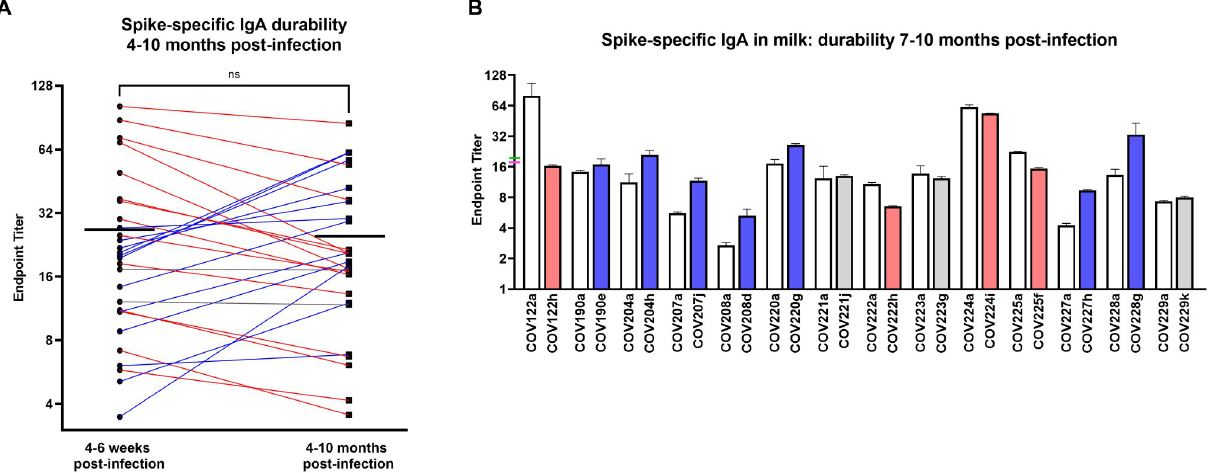
Fig 3. The Spike-specific IgA response in milk after SARS-CoV-2 infection is highly durable over time. (A) IgA endpoint titers determined from Spike ELISA for 28 pairs of milk samples obtained from COVID-19-recovered donors 4–6 weeks and 4–10 months after infection are shown. Mean endpoint values for each group are shown. Blue lines: > 10% increase, red lines: > 10% decrease, grey lines: < 10% change. NS: not significant. A paired t- test (2-tailed) was used to assess significance. (B) IgA endpoint titers for a subset of 14 paired samples obtained 4–6 weeks and 7–10 months after infection. Mean with SEM is shown. Mean endpoint values for the 4–6 week and 7–10 month groups are indicated on the y-axis as green and pink ticks, respectively. Blue bars: > 10% increase, red bars: > 10% decrease, grey bars: < 10%